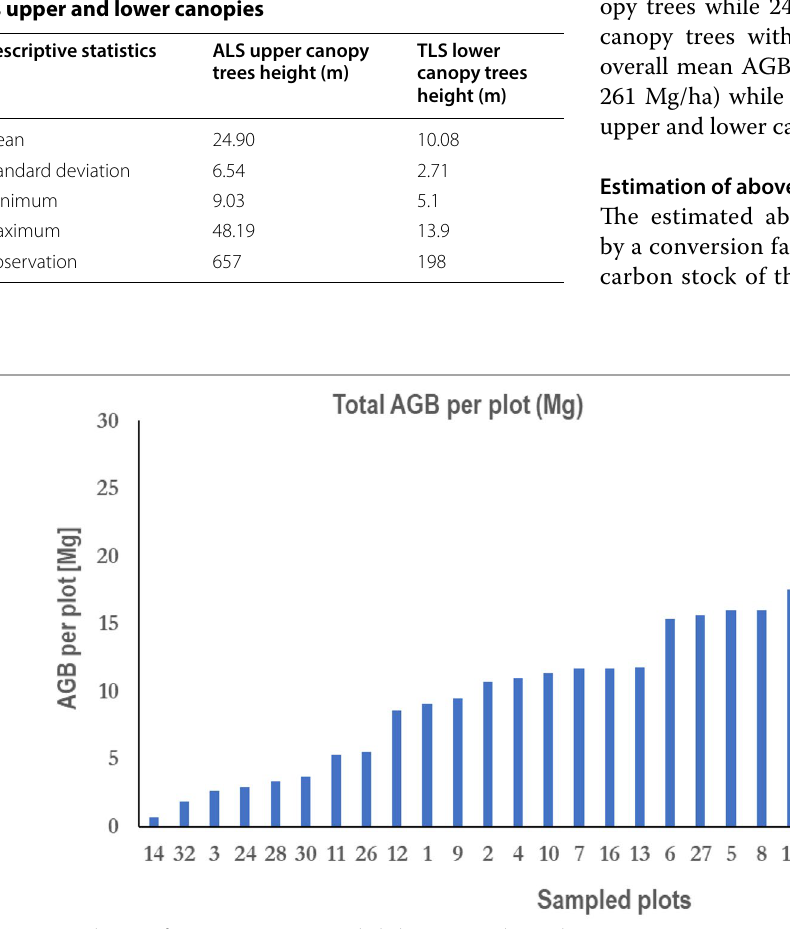
Fig. 6 Distribution of AGB in Mg across sampled plots in ascending